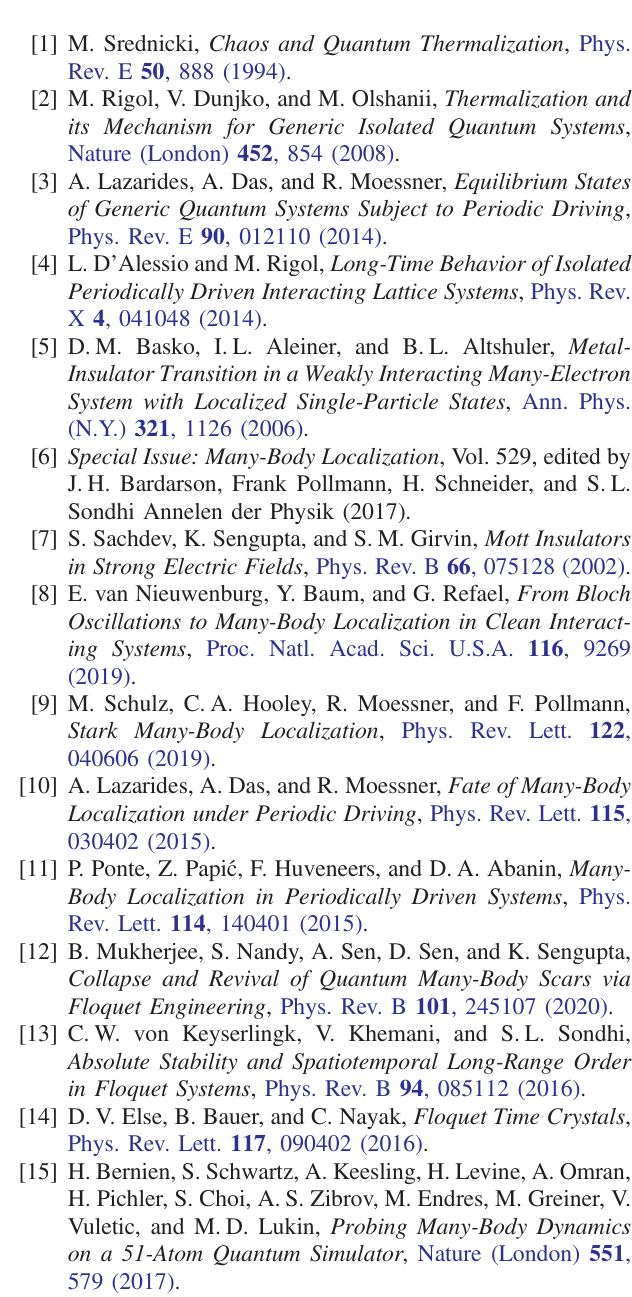
.FIG. 9. Mismatches between the numerical dips in m x first-order FDPT prediction [vertical lines obtained from Eq. (42)]. The parameters are chosen such that the condition for a scar is not satisfied, i.e., h x D ≠ n ω